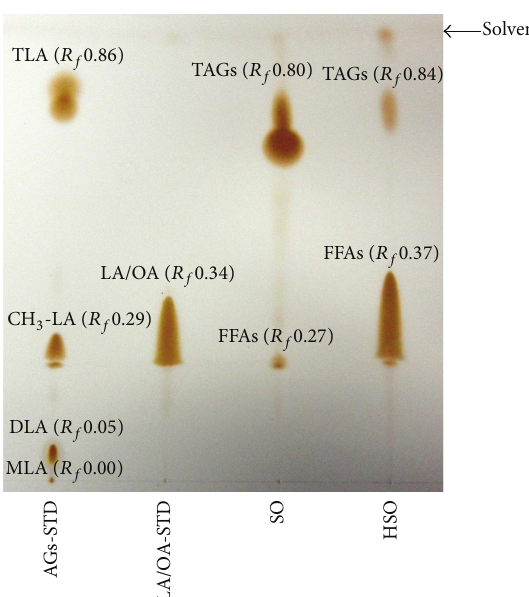
Figure 6: Thin-layer chromatography separation of the compo- nents of safflower oil (SO) and hydrolyzed safflower oil (HSO) by lipase from Candida rugosa . Acylglycerols standard (AGs-STD) was composed of 25% equal amount of methyl linoleate (CH 3 - LA), monolinolein (MLA), dilinolein (DLA), and trilinolein (TLA), whereas a mixture of free fatty acid standards (LA/OA-STD) was composed of 67% linoleic acid (LA) and 33% oleic acid (OA). Free fatty acids, FFAs, and triacylglycerols, TAGs. Retention factor ( 𝑅 𝑓 ) was defined as the migration distance of a component over that of the